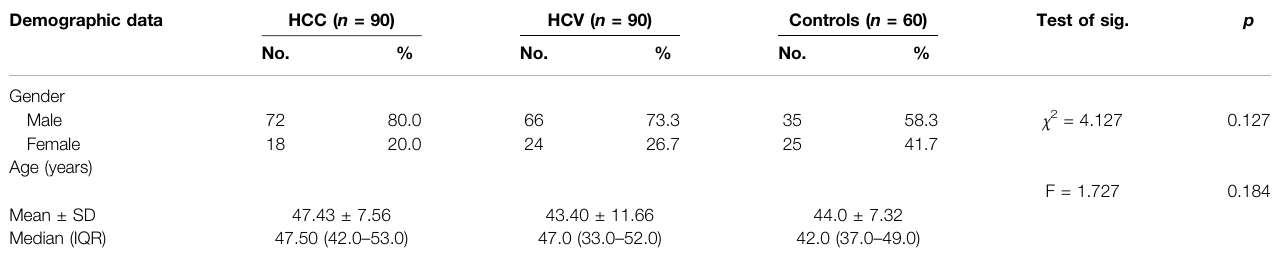
TABLE 1 | Comparison between the studied groups according to demographic data. Demographic data